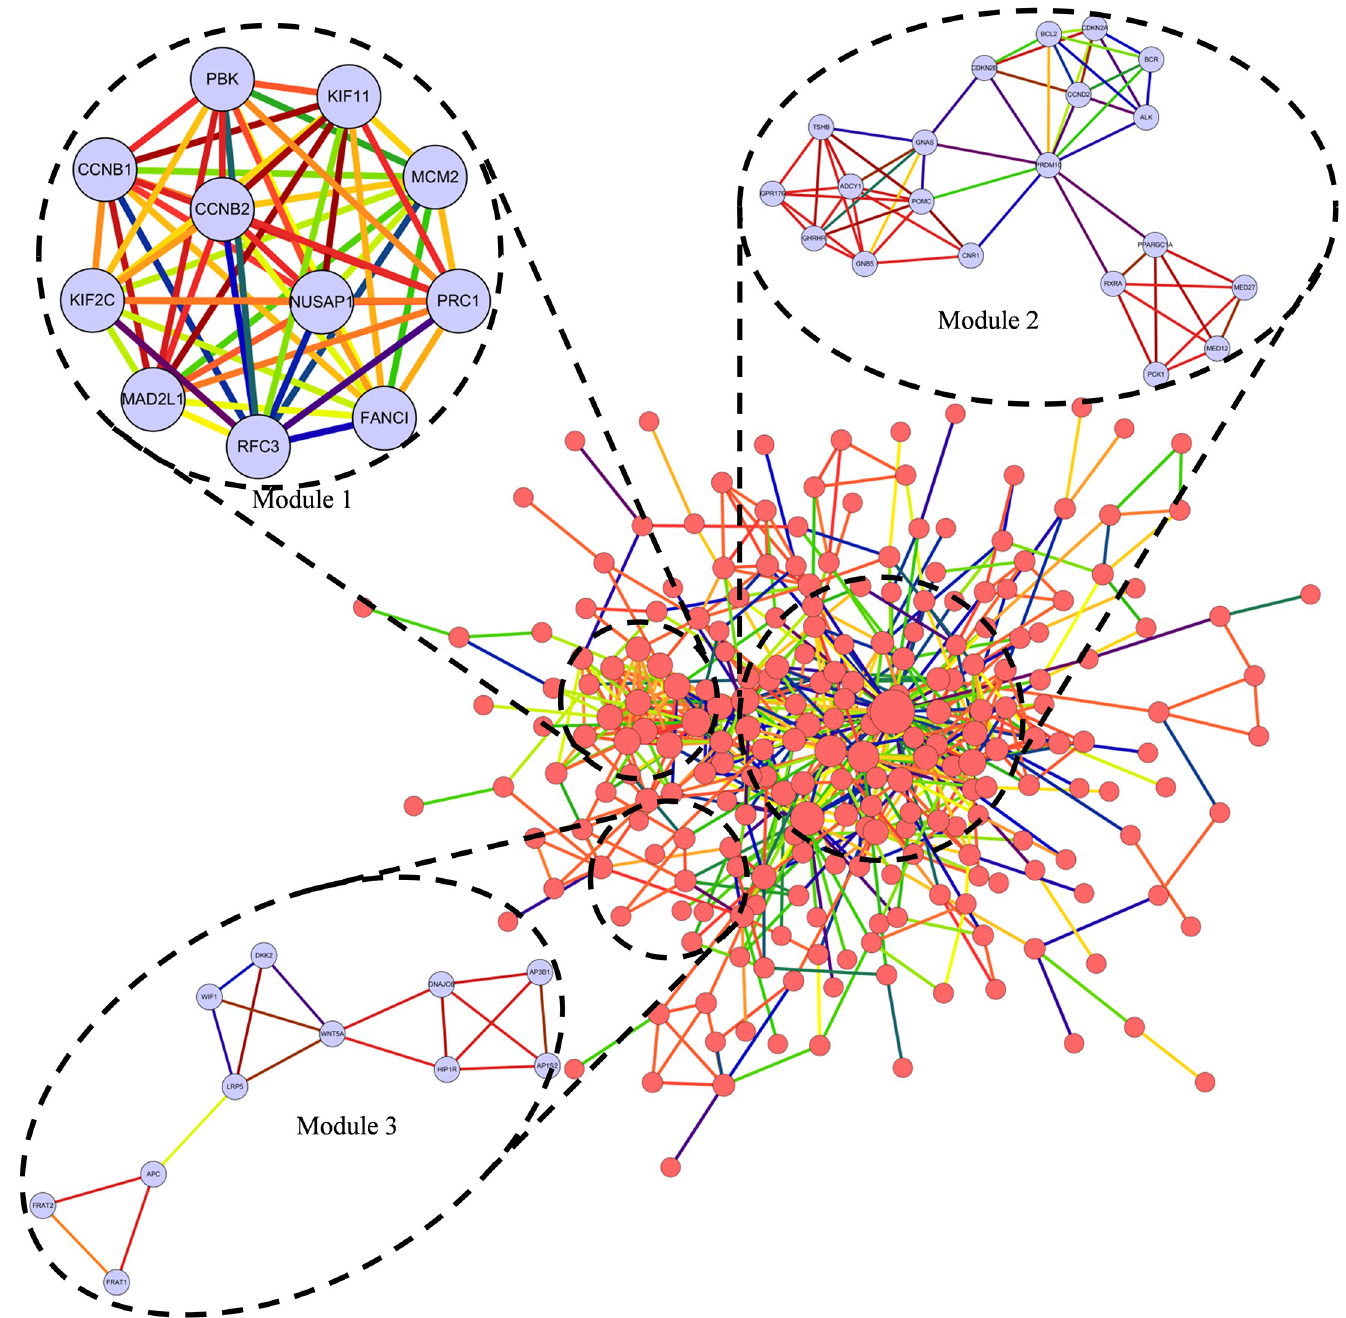
Fig 3. Top 3 modules from the protein-protein interaction